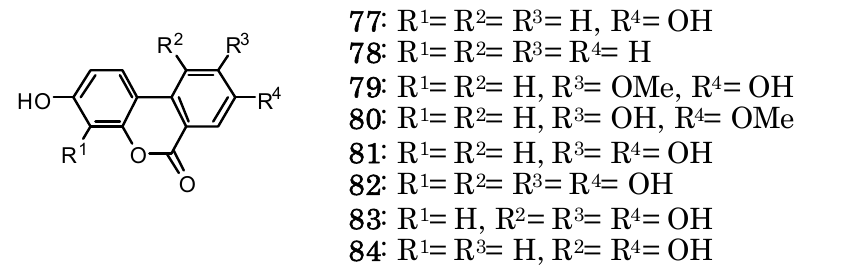
Figure 14. Structures of metabolites from